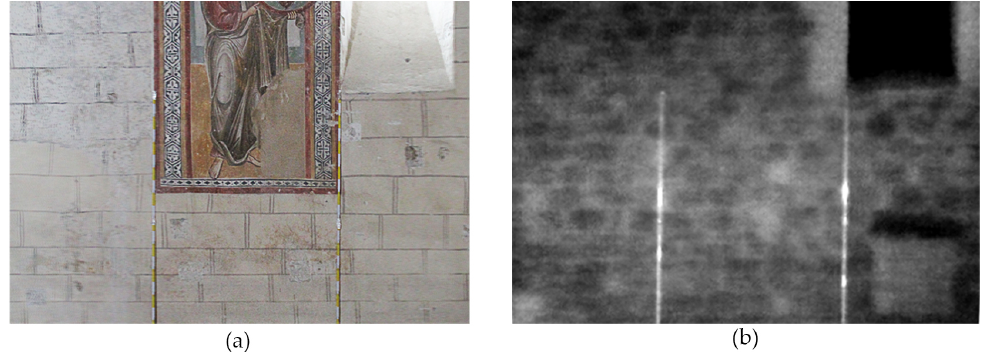
Figure 11. ( a ) One the frescoes under investigation, in particular the one near the apse. In the pictures, the reflective meter-sticks located as reference points for the subsequent post-processing are visible. ( b ) Thermal image with improved contrast in which are visible the structural peculiarities of the masonry wall, in the right corner is observable the former recess (see the cones of vision 5 and B in Figure 2).